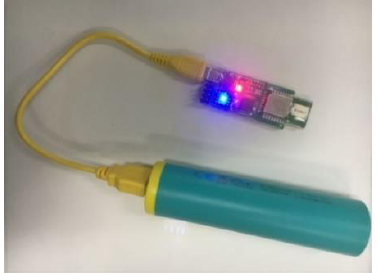
Figure 13. The ultra-wideband (UWB) node connected with power supply.